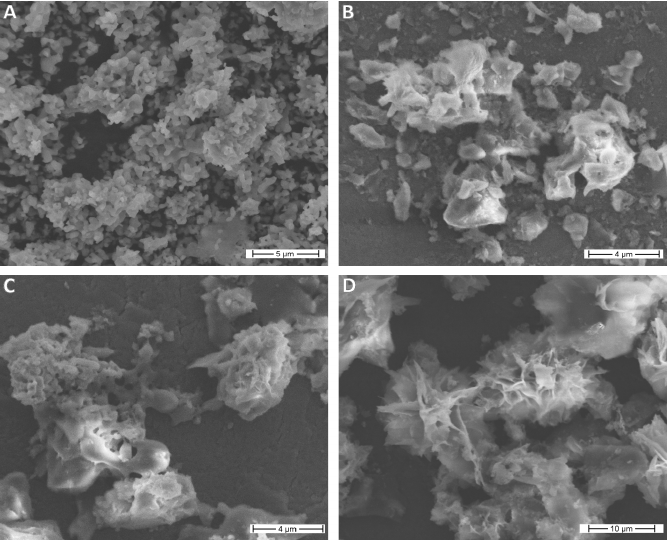
Figure 4. SEM images of ( A ) β -TCPco-doped with Ce 3+ and Pr 3+ ions, ( B ) PLLA, ( C ) PLLA with β -TCP composite with phosphate:polymer 1:10 ratio, and ( D ) PLLA with β -TCP composite with phosphate:polymer 1:20 ratio.